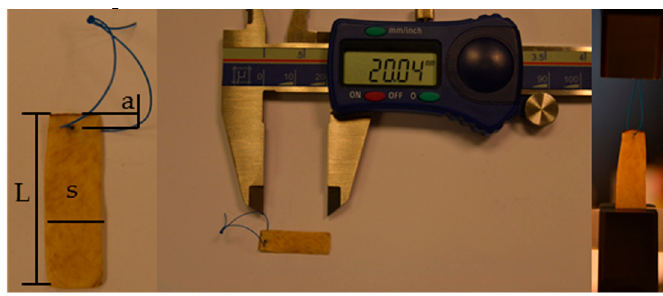
Figure 13. Suture retention strength sample preparation.